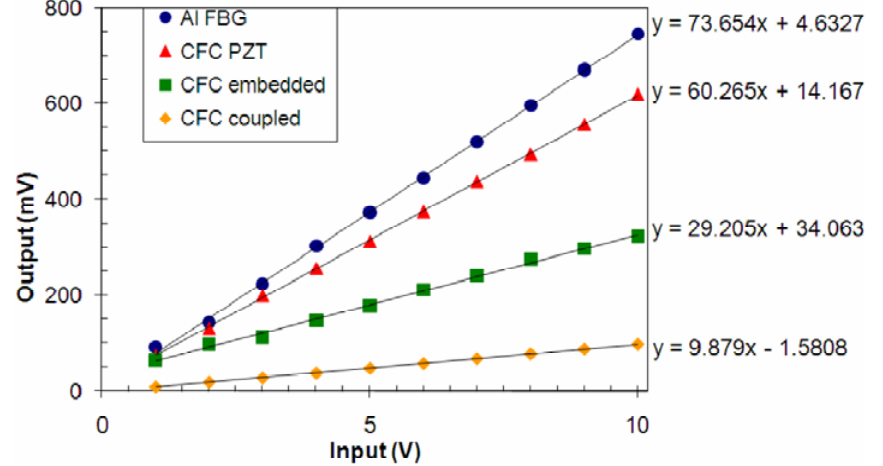
Figure 6. Transfer functions of the acoustic communications